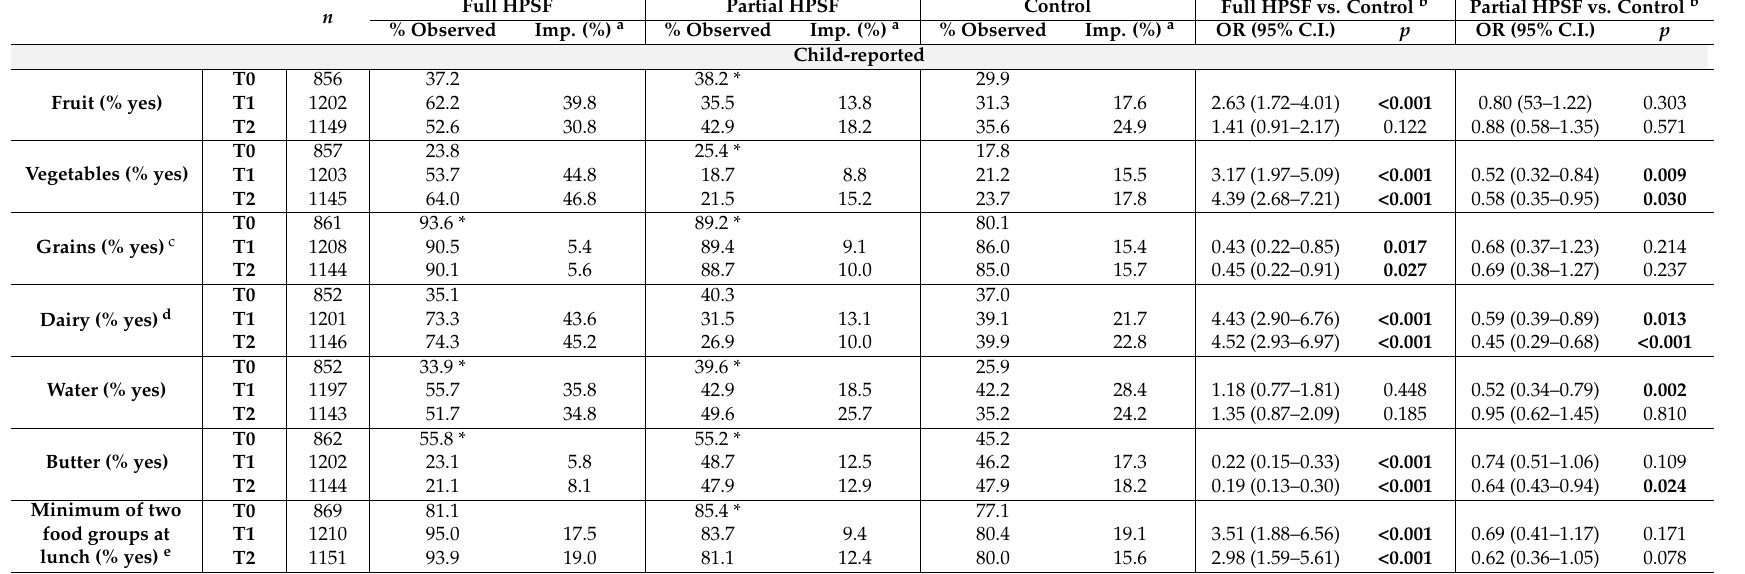
Table 3. Children’s lunch intake: Observed descriptives and estimated 1- and 2-year